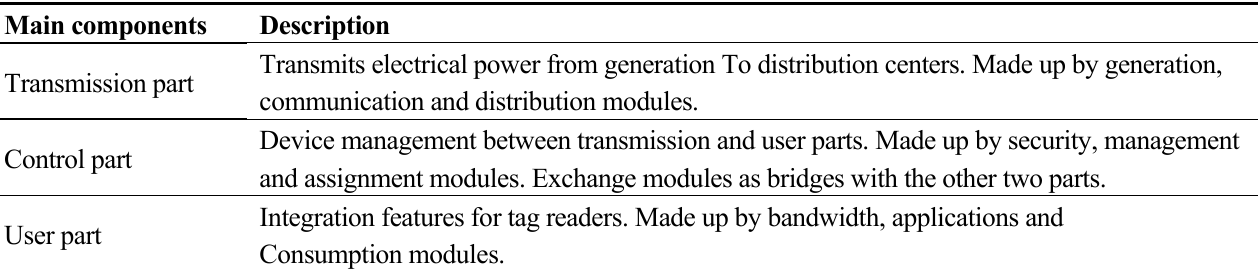
Table 2. Description of Service-Oriented Middleware for Smart Grid main